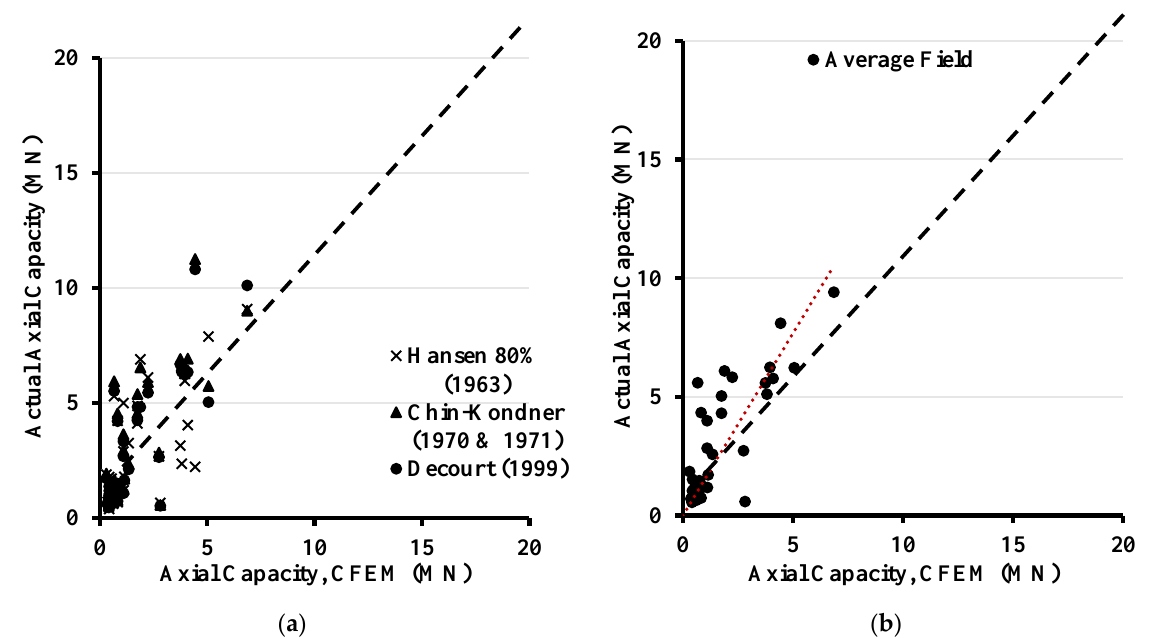
Figure 4. Comparison between the theoretical axial capacity in drilled (bored) piles determined using the CFEM method and ( a ) the field results, and ( b ) the average field